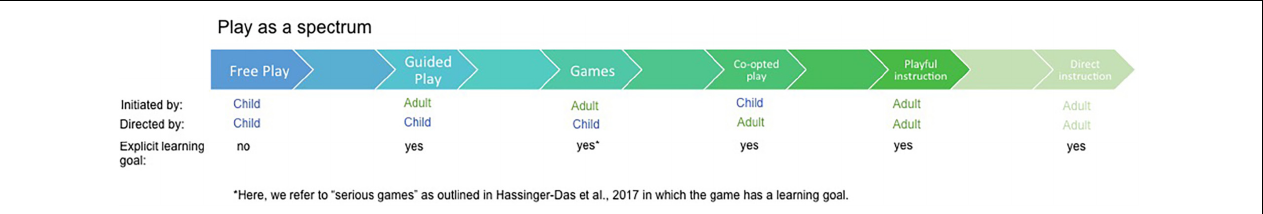
FIGURE 1 | Play conceptualized as a spectrum captures playful experiences that differ along a continuum in terms of initiation and direction of the experience and whether or not there is a learning goal.